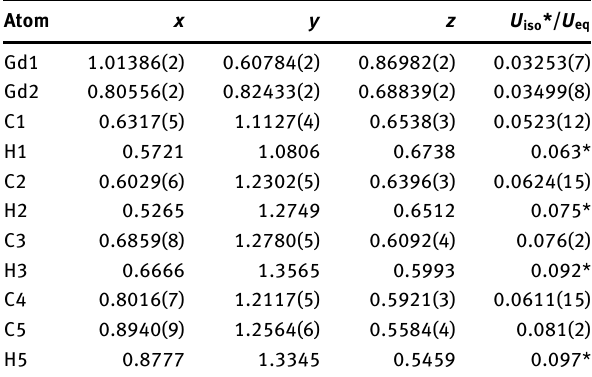
Table 2: Fractional atomic coordinates and isotropic or equivalent isotropic displacement parameters (Å 2